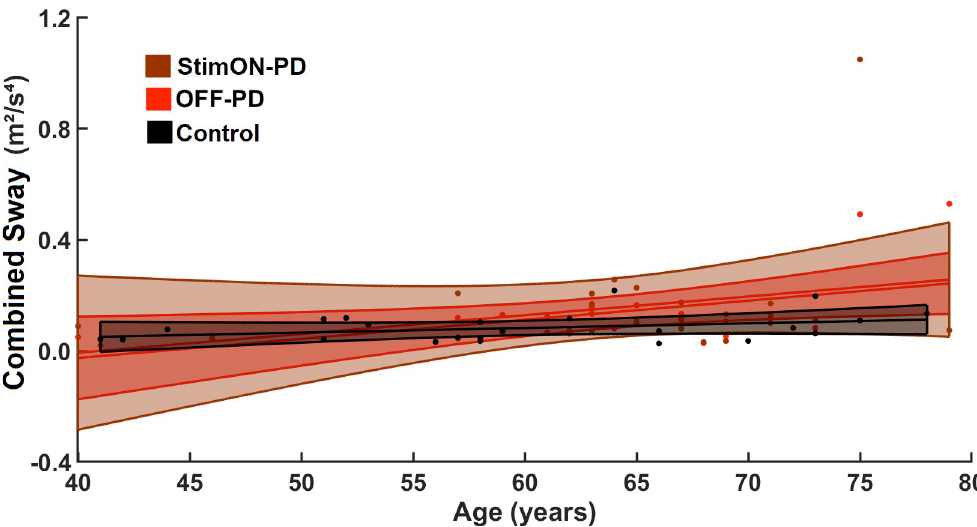
Fig 6. Age-related changes in combined sway values. The linear regressions between the age and the combined sway values are presented in the Parkinson group during bilateral stimulation ON (StimON)-PD, no stimulation (OFF)-PD, and in the healthy control group (Control). Combined sway worsened with age in the PD group in the StimON and OFF stimulation conditions, but not in the control group.